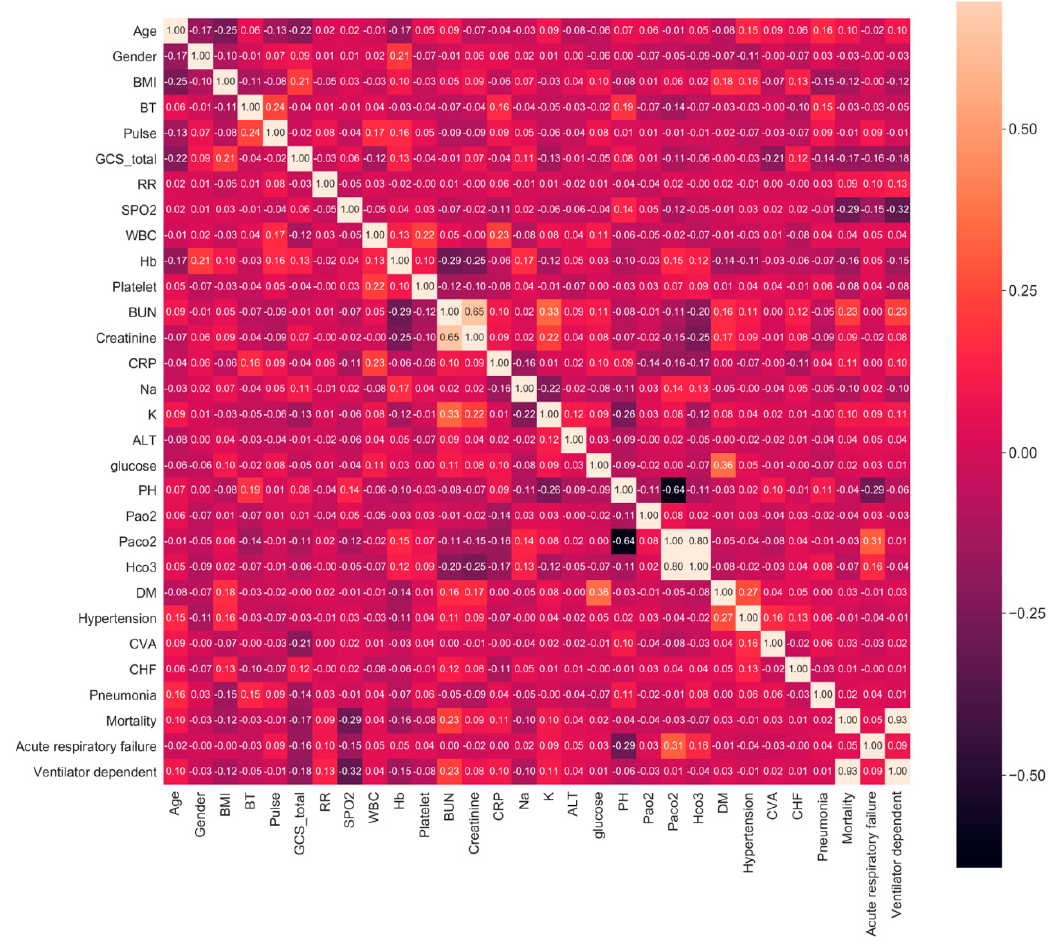
Figure 2. Spearman correlation.